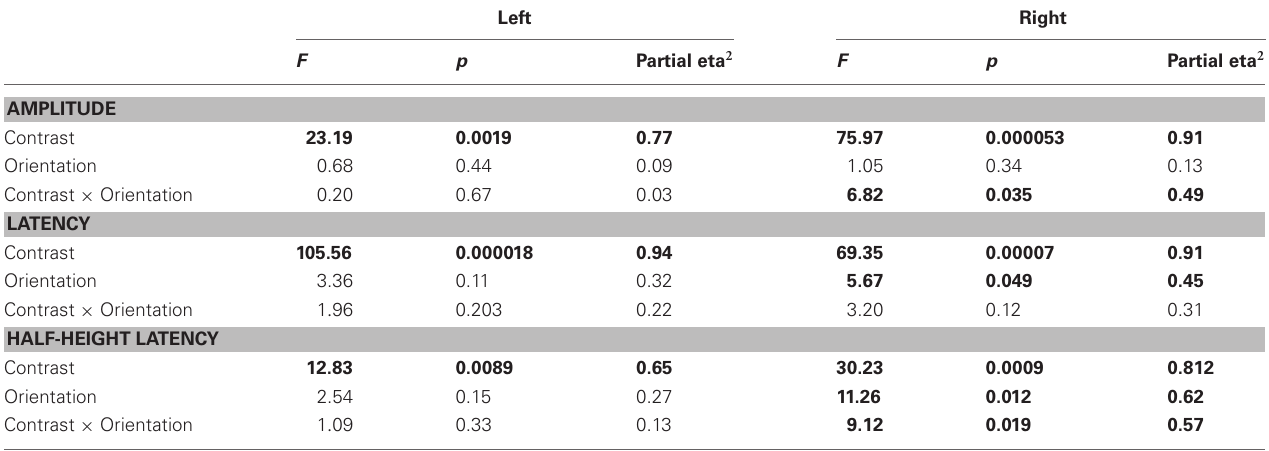
Table 1 | Results of the repeated-measure ANOVAs performed with factors Contrast (High and Low) and Orientation (/ and #) on Amplitudes, Latencies, and Half-height latencies. Left